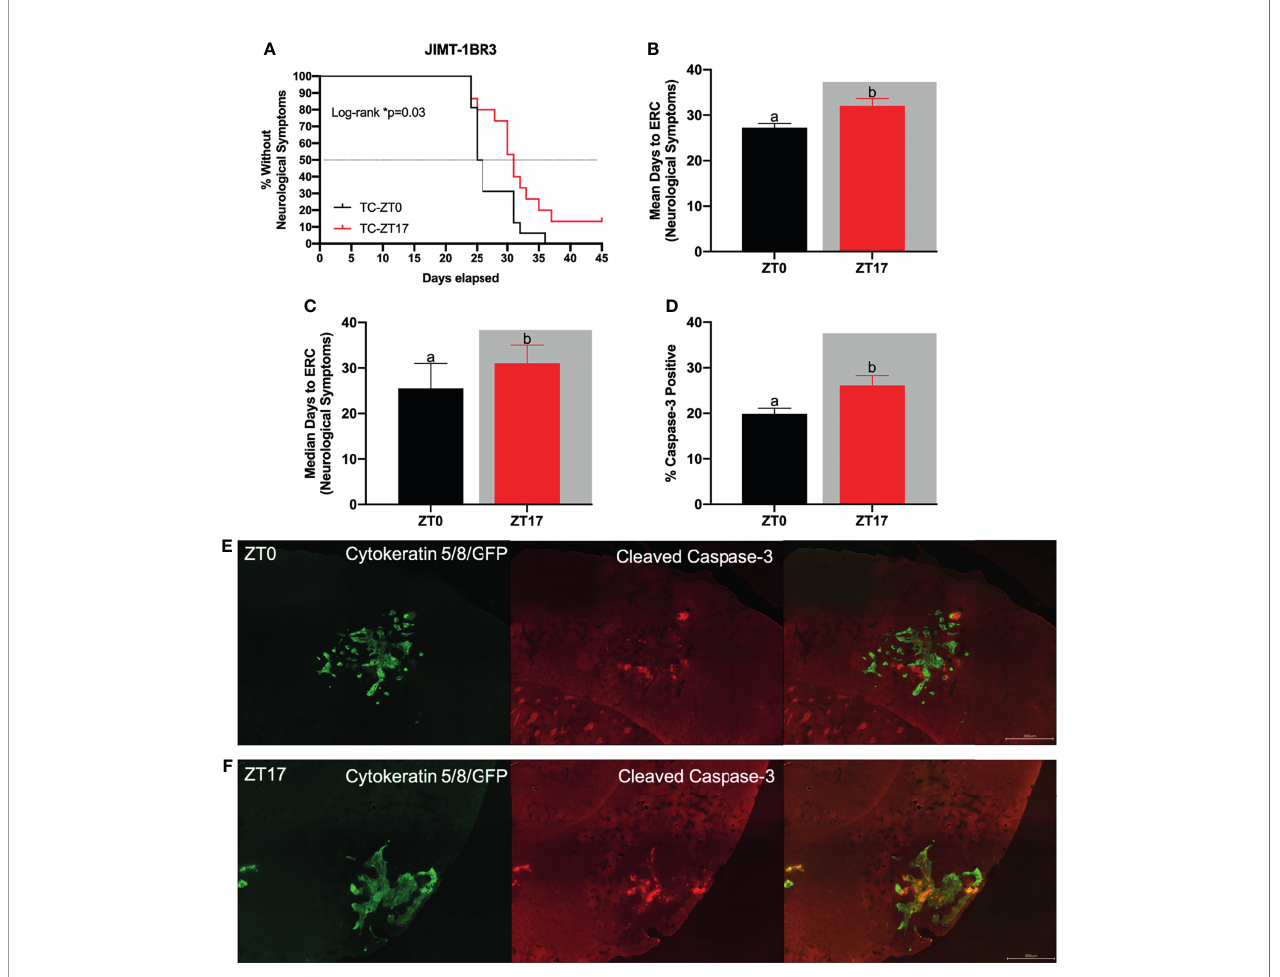
FIGURE 2 | Optimal timing of chemotherapy delays onset of neurological symptoms and increases cell death within JIMT-1BR3 BMBC. (A) Mice harboring BMBC and receiving paclitaxel injections at ZT17 (ie TC-ZT17, n=15) demonstrated prolonged onset of neurological symptoms relative to mice harboring BMBC and receiving paclitaxel injections at ZT0 (i.e., TC-ZT0, n=16). Mice receiving paclitaxel injections alone did not display neurological de fi cits irrespective of administration time (i.e., C-ZT0, n=14 and C-ZT17, n=15). Additionally, mice harboring BMBC and receiving paclitaxel injections at ZT17 demonstrated signi fi cantly prolonged (B) mean and (C) median number of days until the onset of neurological symptoms and signi fi cantly increased (D) cell death with BMBC relative to ZT0. (E, F) Representative images of cell death within BMBC at ZT0 and ZT17. For negative controls see Supplemental Figures 1 and 2 . Green- cytokeratin 5/8/GFP, Red- cleaved caspase-3. (B. n= 16,15 respectively; (C) n= 16,15 respectively; (D) n= 11, 11 respectively). The data are presented as mean +SEM for (B, D) and median +95% CI for (C) . Graph bars that do not share a letter are statistically signi fi cantly different at p<0.05. * Log-rank p<0.05. (A) Log-rank test (B) unpaired t -test (C) Mann Whitney test (D) unpaired t